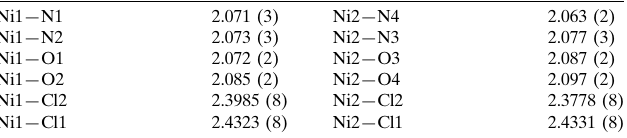
Selected bond lengths (A˚ ).